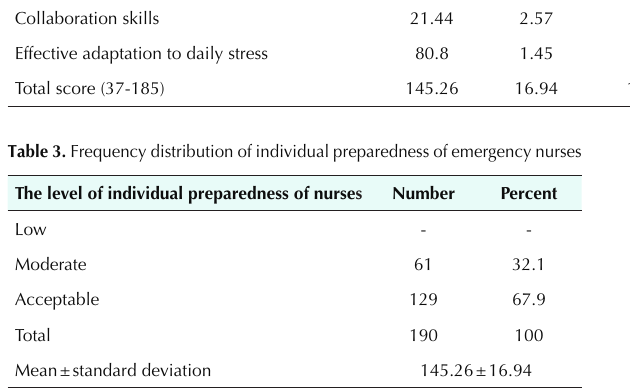
Table 2 . Mean ± standard deviation of individual preparedness of emergency nurses in six domains Domains (n = 6) Mean SE Minimum